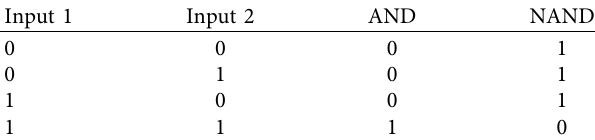
Table 1: Truth table of AND gate and NAND